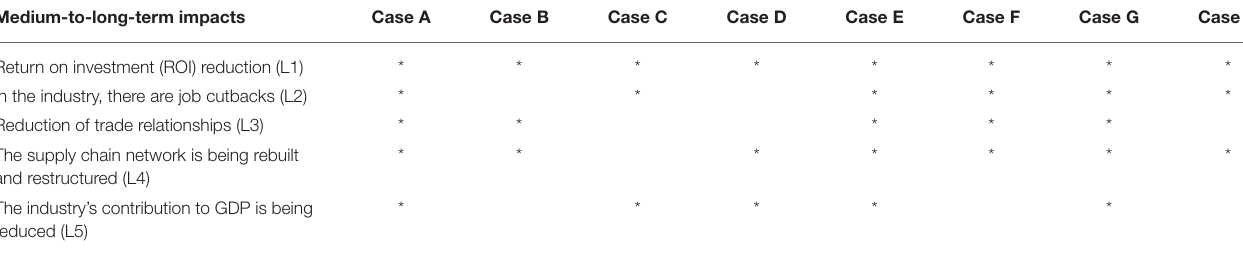
TABLE 3 | The medium-to-long-term impacts of the COVID-19 on Strategic emerging industries. Medium-to-long-term impacts